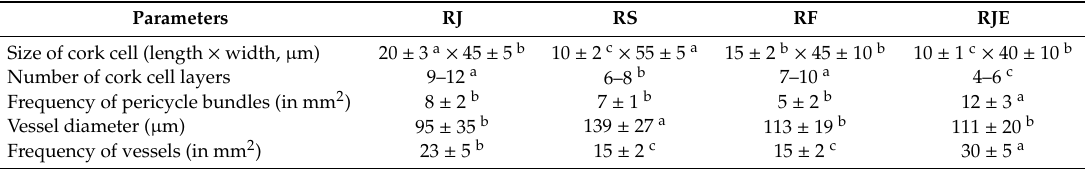
Figure 5. Photomicrographs of the roots from four Reynoutria plants: ( a ) and ( b ) transverse section of the root. The black bars mean 100 µ m. cr : cork; ph : phloem; pb : pericycle bundle; v : vessel. Table 5. Anatomical characteristics of the root from four Reynoutria plants.